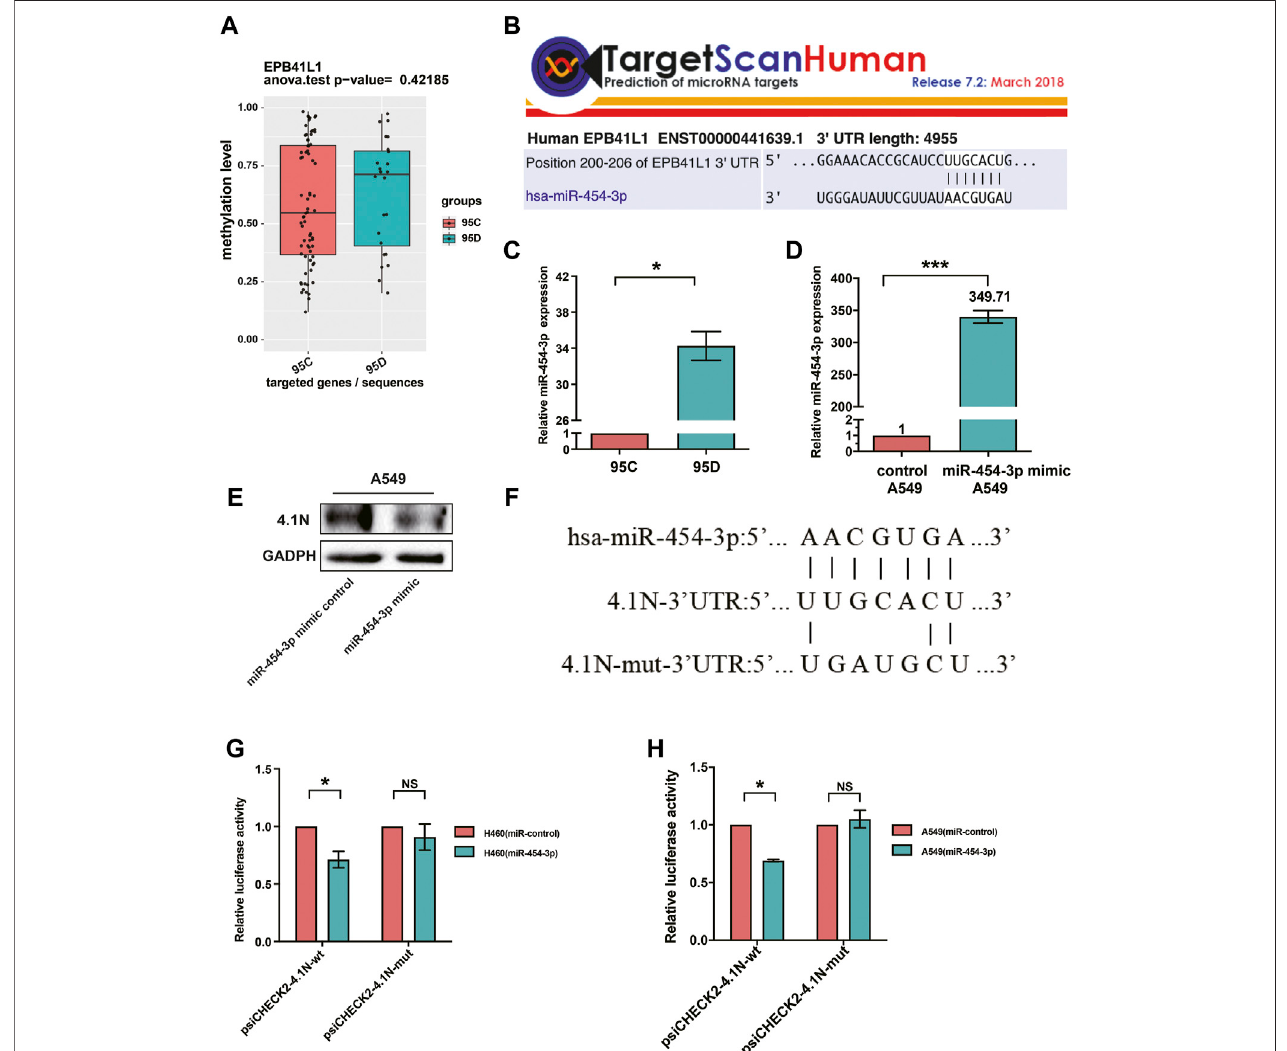
FIGURE5| MiR-454-3pdirectlyboundto3 ′ UTRof4.1N/ EPB41L1 mRNA. (A) Therewasnosigni fi cantdifferenceinmethylationlevelsofthe4.1N/ EPB41L1 gene promoter between the two homologous NSCLC subclones 95C and 95D. (B) MiR-454-3p was a predicted binding partner of 4.1N/ EPB41L1 . (C,D) After transfecting A549 cells with miR-454-3p or negative control mimics, the expression levels of miR-454-3p and protein 4.1N/ EPB41L1 were detected using qPCR and Western blot, respectively. (E) miR-454-3pexpressionwassigni fi cantlylowerin95Ccellsthan95Dcells. (F) SchematicrepresentationofthepredictedbindingsitesofmiR-454- 3p and 4.1N/ EPB41L1 mRNA and the mutated sequences in potential binding sites. (G,H) A549 or H460 cells were co-transfected with miR-454-3p or control mimics andwild-type(psiCHECK2-4.1N-wt)ormutant-type(psiCHECK2-4.1N-mut)plasmids.48hlater,dual-luciferaseactivitywasmeasured.Thedatawerepresentedasthe mean ± SD. * p < 0.05 GADPH and U6 were used as loading control of 4.1N/ EPB41L1 mRNA and miR-454-3p, respectively.